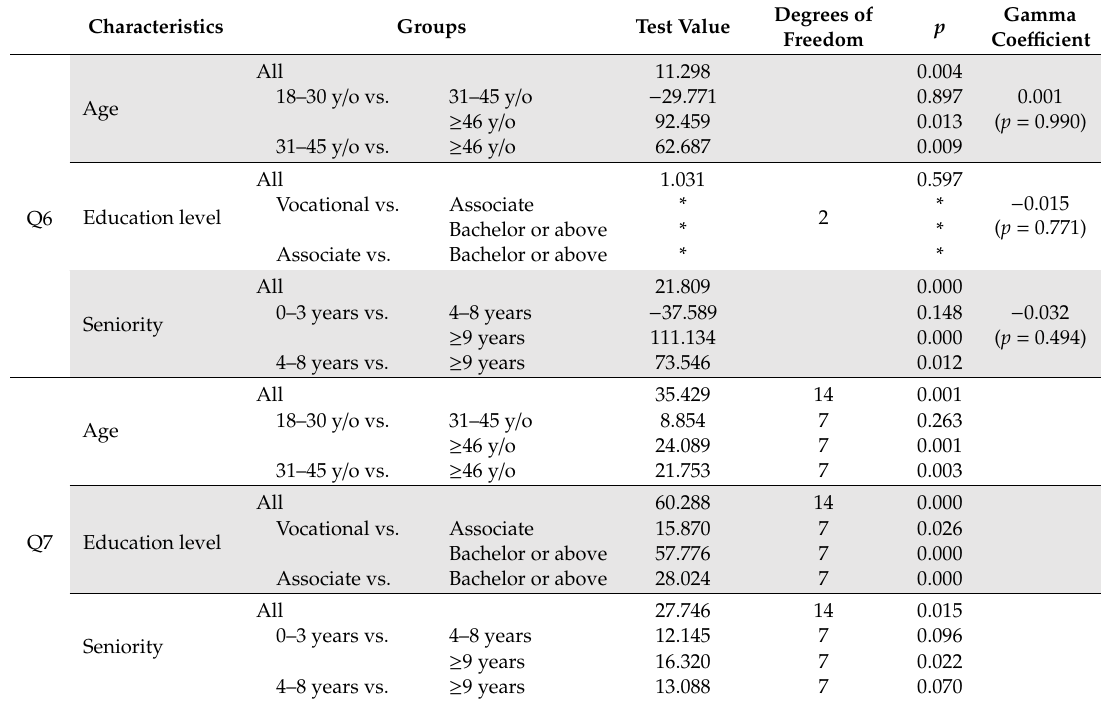
Table 2. Di ff erences between age, education level, and seniority groups for Q6 (frequency of feeling incapable) and Q7 (impact of insu ffi cient